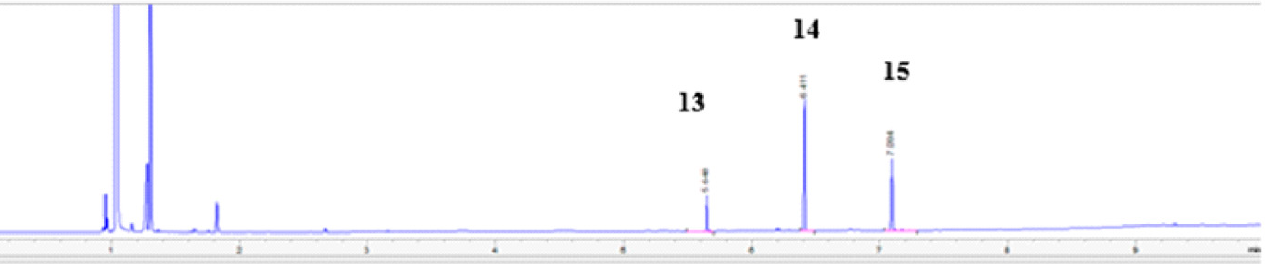
Figure 7. Chromatogram crude extract of mixture alcohols 13–15 .